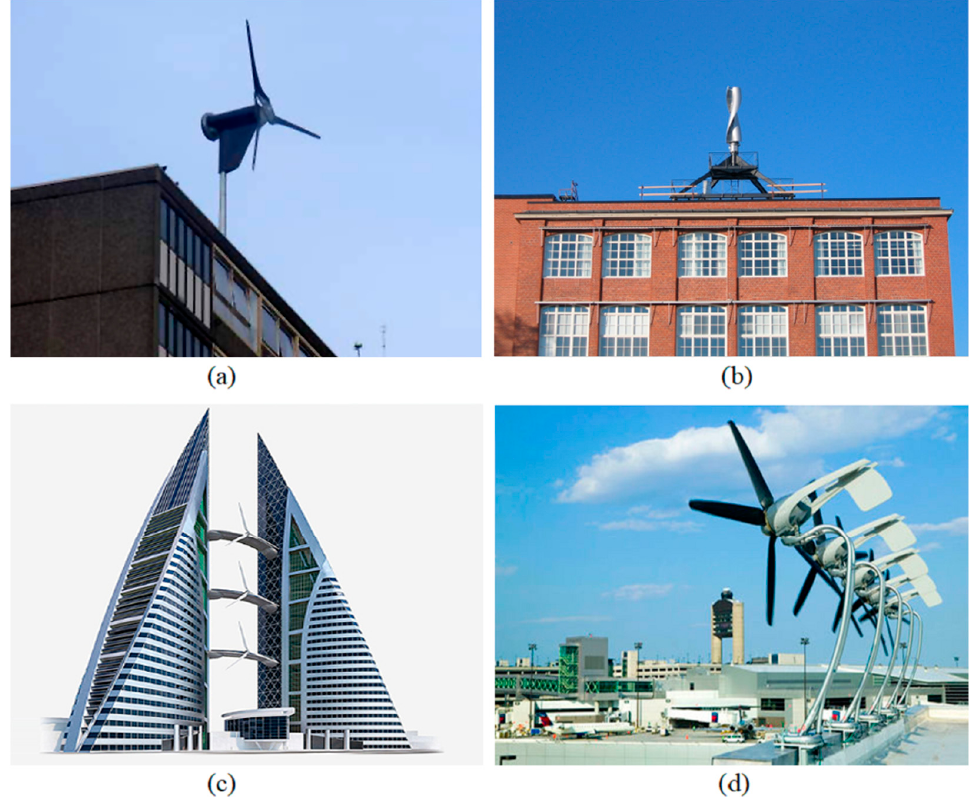
Figure 2. Examples of practical implementations of small wind turbines. ( a ) Ashenden building, London, UK (adapted from [11]) ( b ) University of Vaasa, Finland (adapted from [12]) ( c ) Bahrain WTC twin towers (adapted from [12]) ( d ) Group of SWT in Boston Logan Airport, (adapted from [12]). The installation of multiple SWT is also a frequent configuration. The Bahrain World Trade Center is a 240 m high building, and it was projected to accommodate three vertical axis wind turbines measuring 29 m in diameter as part of its architectural design, as shown